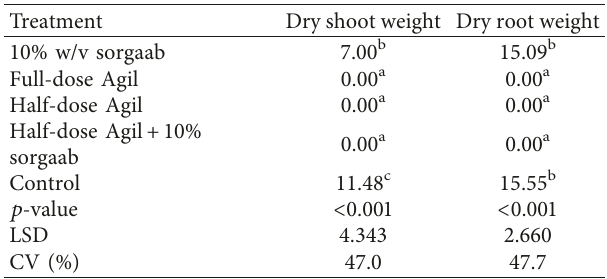
Table 7: Effect of postemergence herbicidal treatments on the dry shoot weight and dry root weight of goose